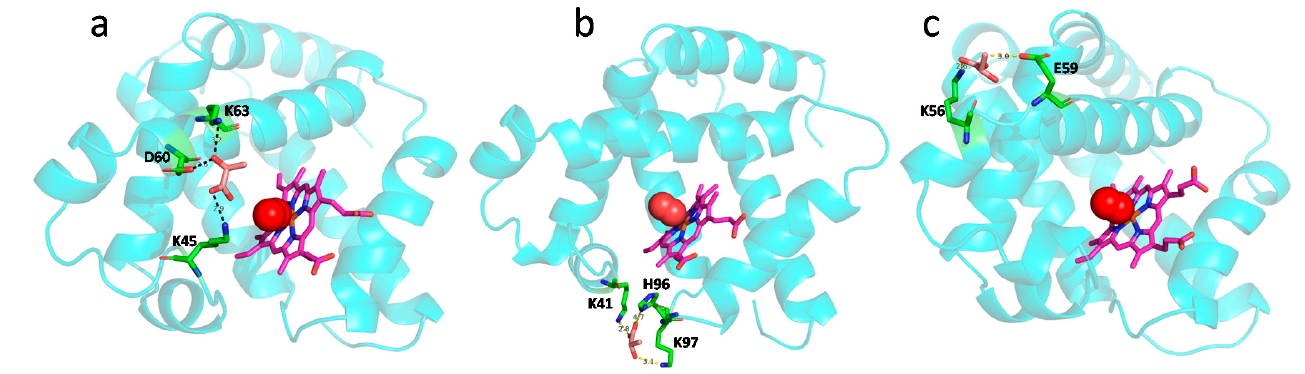
Figure 2. Autodock results displaying LAC interaction with oxy-Mb residues at ( a ) pH 7.0, ( b ) pH 6.4, and ( c ) pH 6.0. At pH 7.0, LAC shows interaction with residues K45, K63, and D60, while at pH 6.4, LAC shows interaction with residues K41, H96, and K97, and at pH 6.0, LAC shows interaction with residues K56 and E59. LAC (brown), heme center (pink), and the residues (green) interacting with LAC are displayed as sticks. Mb protein (cyan) is displayed as ribbon structure an oxygen (red) in spheres. Possible hydrogen bond interactions between side chains of residues and LAC are displayed as dashed yellow lines with bond length.